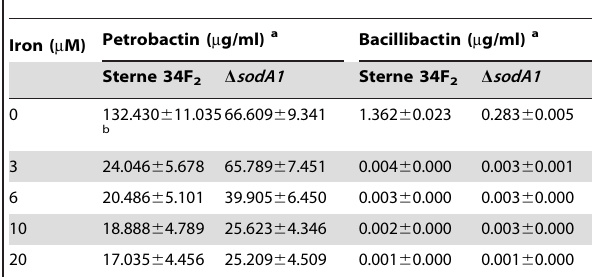
a Concentration of siderophores petrobactin and bacillibactin is expressed as m g/ml of supernatant from IDM cultures of B. anthracis . b Quantification was performed three times from the independent extraction and values represent means 6 standard